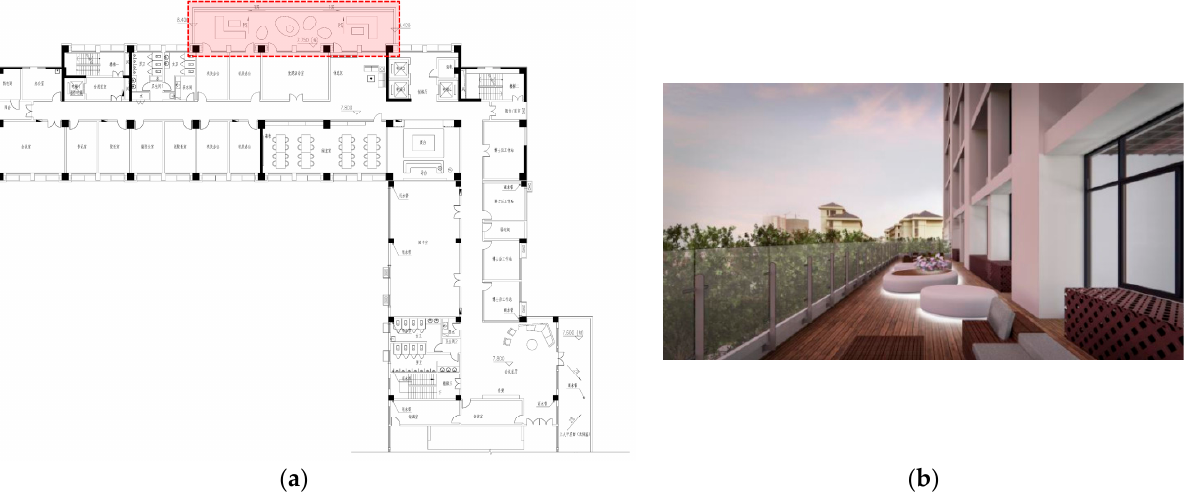
Figure 7. The third-floor terrace after optimal design. ( a ) Optimized plan. ( b ) Rendering of the space after optimal design.